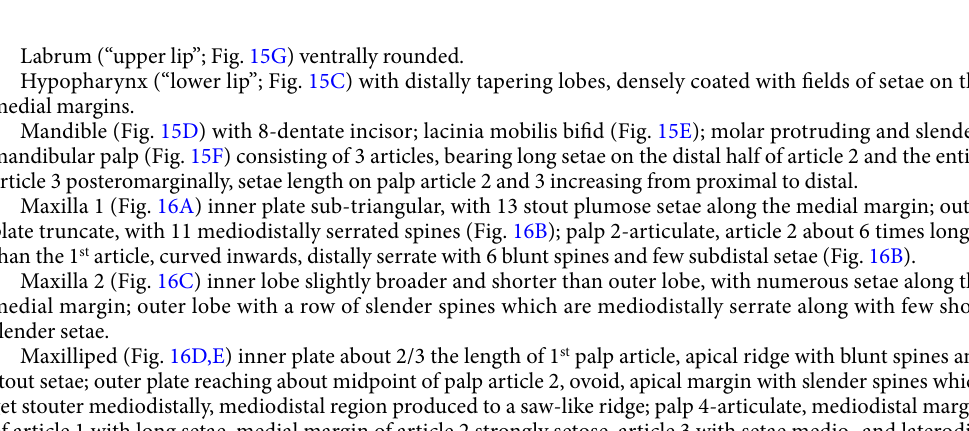
Figure 16. Epimeria cornigera , neotype, adult female, northern North Sea, NHMUK 2015.3268: ( A ) maxilla 1, ( B ) maxilla 1 palpus and outer plate distal ends lateral view, ( C ) maxilla 2, ( D ) maxilliped, ( E ) maxilliped palpus and outer plate; scales: (A,C,D,E) 0.5 mm; (B) 0.1